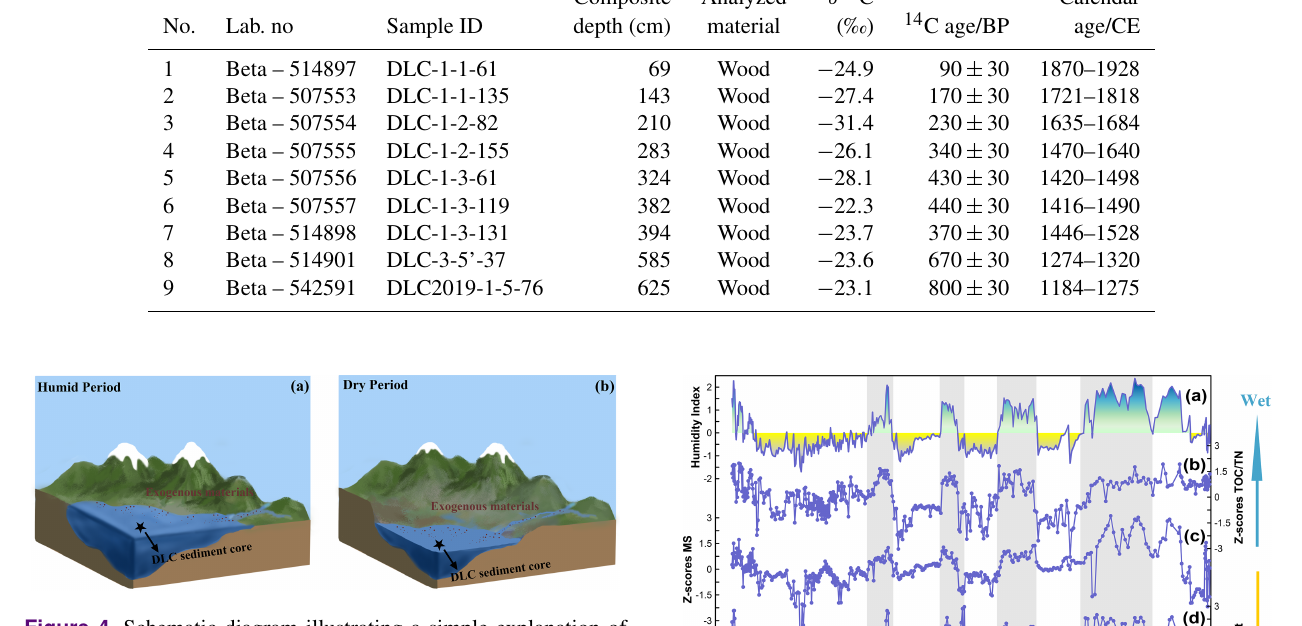
Figure 4. Schematic diagram illustrating a simple explanation of the lacustrine depositional process in the Lake Dalongchi region. Lake level condition and the transport process of exogenous mate- rials in the humid period (a) and the dry period (b) .